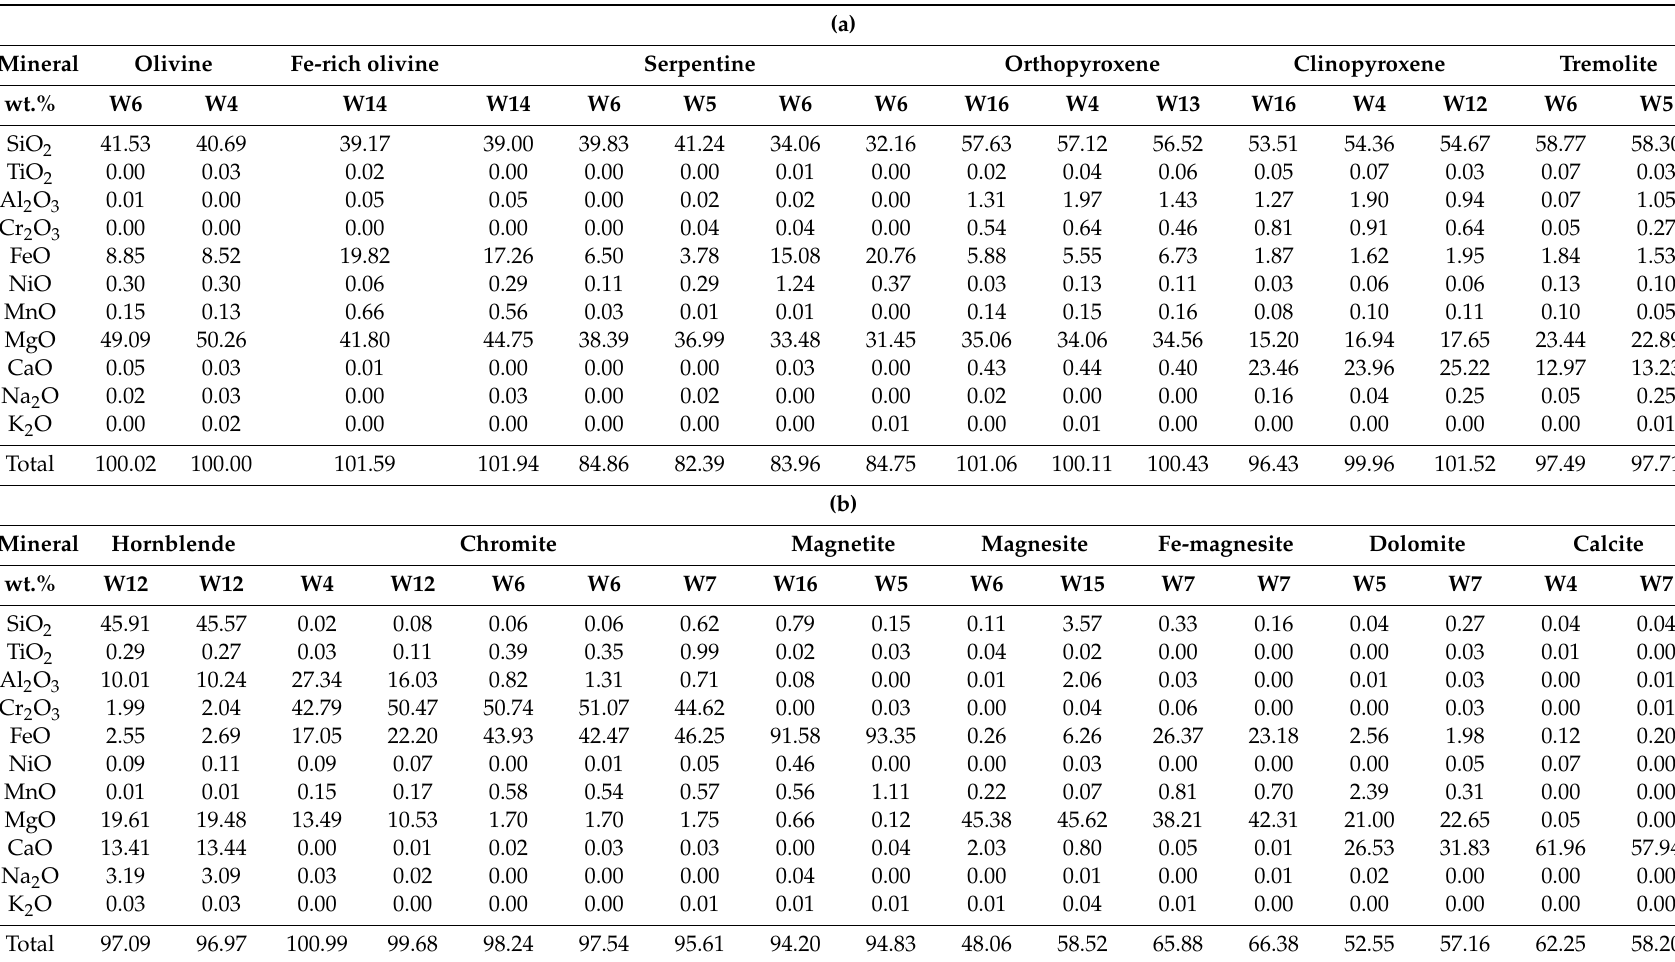
Table 4. Representative analyses (EMPA) of the peridotite